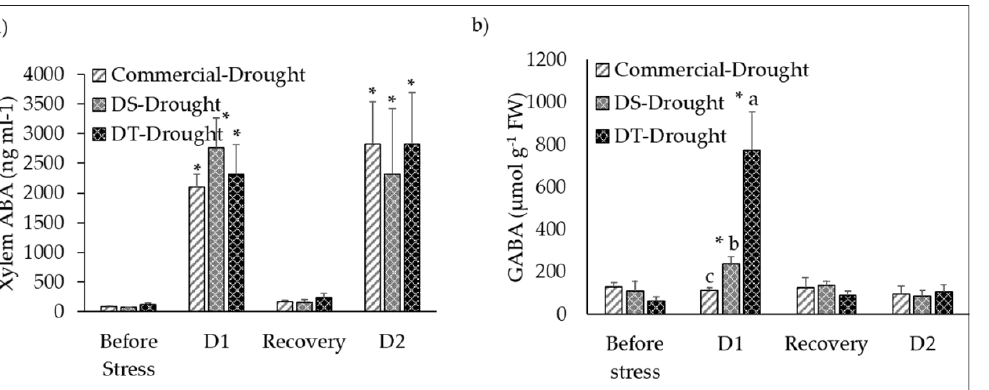
Figure 7. Variations in ( a ) ABA concentrations in the xylem sap (ABA xyl ) and, ( b ) GABA concentra- tions in leaves of Cabernet clones upon exposure to two dehydration events. Values are means ± SEM of six biological replicates. Statistical analysis was conducted using two-way ANOVA. Asterisks indicate statistically significant differences ( p < 0.05) of clones relative to well-watered conditions. Lowercase letters indicate statistically significant differences ( p < 0.05) between drought treated clones within each